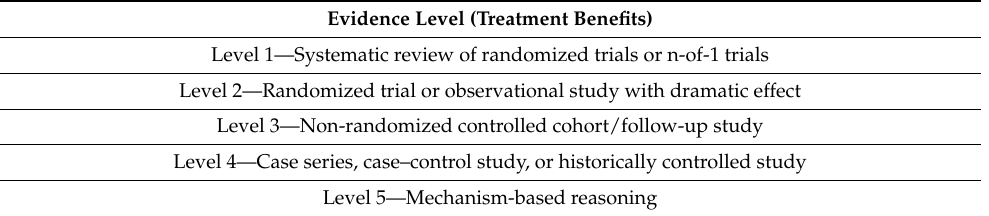
Table 1. The Oxford 2011 Levels of Evidence [35].